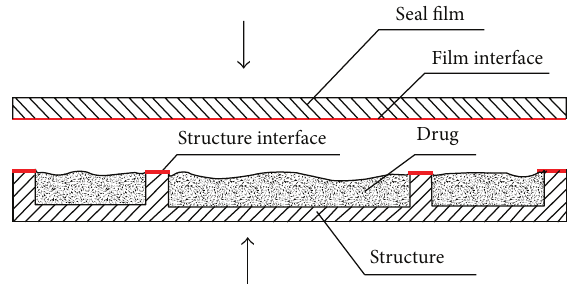
Figure 1: Schematic design of biodegradable microstructure for drug delivery